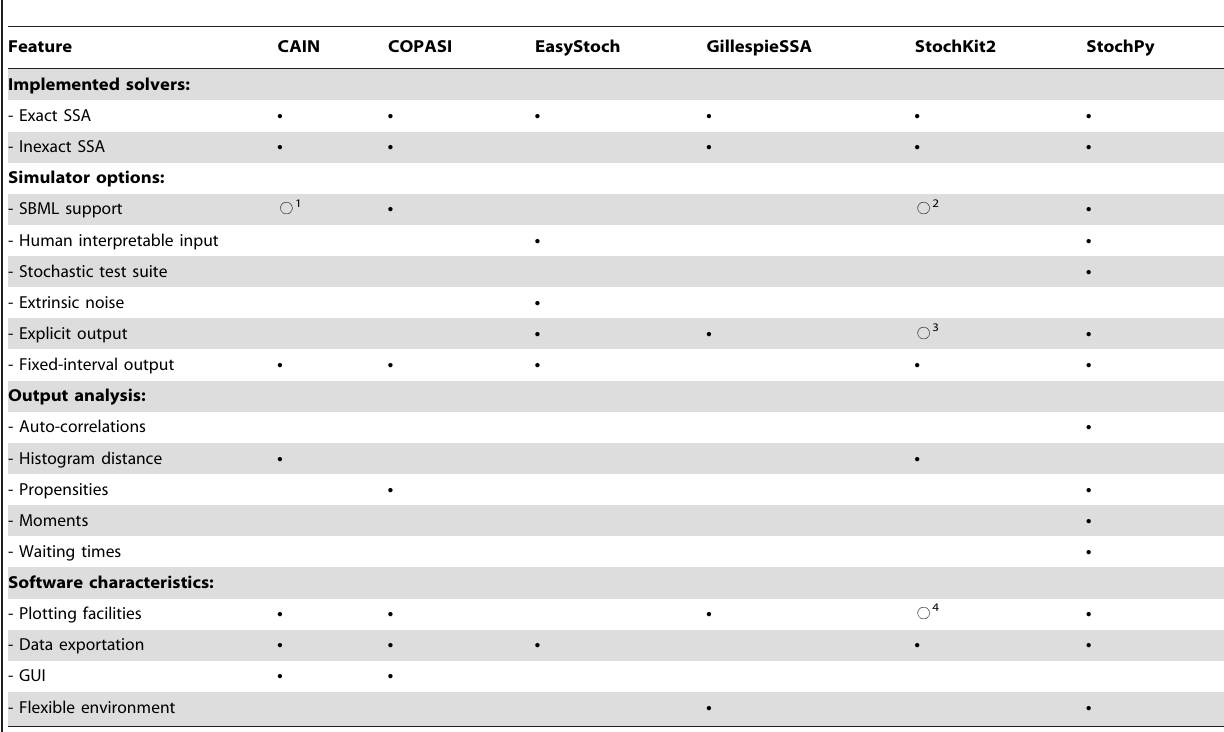
Table 1. Feature comparison between StochPy and existing (stochastic) software.